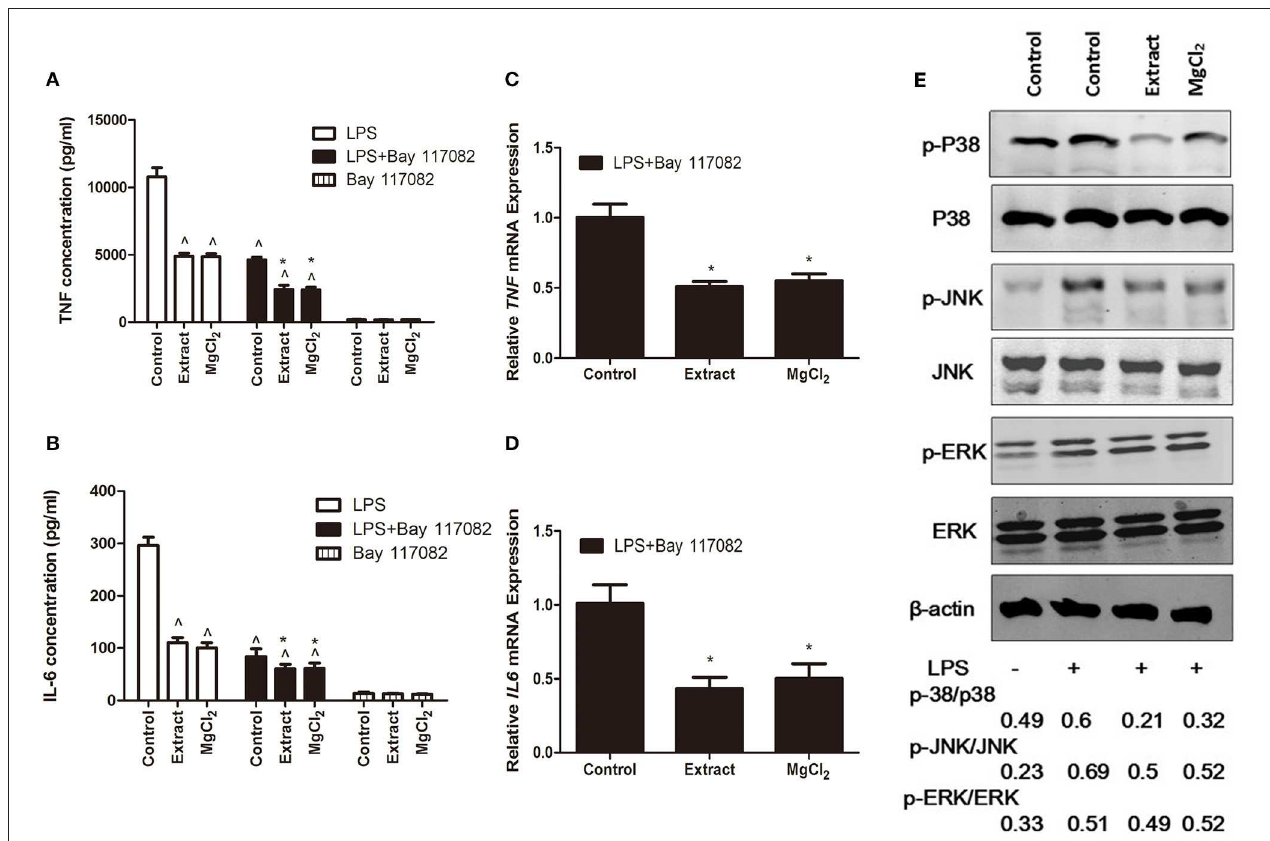
FIGURE 7 | Effects of extract and MgCl 2 on the MAPK inflammatory signaling pathway in LPS-induced THP-1 cell-derived macrophages. THP-1 cell-derived macrophages were pretreated with or without NF- κ B inhibitor (Bay 117082, 5 µ M) for 1h prior to the addition of extract or MgCl 2 for another 1h and then stimulated with LPS for the indicated time. The protein expression of TNF (A) and IL-6 (B) in medium was measured at 24h by ELISA. The mRNA expression of TNF (C) and IL-6 (D) was analyzed at 6h by qPCR. (E) THP-1 cell-derived macrophages were pretreated with extract or extract for 1h and then stimulated with LPS for 45min. The relative expression of p-P38/p38, p-ERK/ERK, and p-JNK/JNK was determined by western blotting. The representative images from three experiments are shown. * P < 0.05 vs. LPS + Bay 117082 control group; ∧ P < 0.05 vs. LPS-induced control group. MAPK, mitogen-activated protein kinase; LPS, lipopolysaccharide; NF- κ B, nuclear factor-kappa B; TNF, tumor necrosis factor; IL,